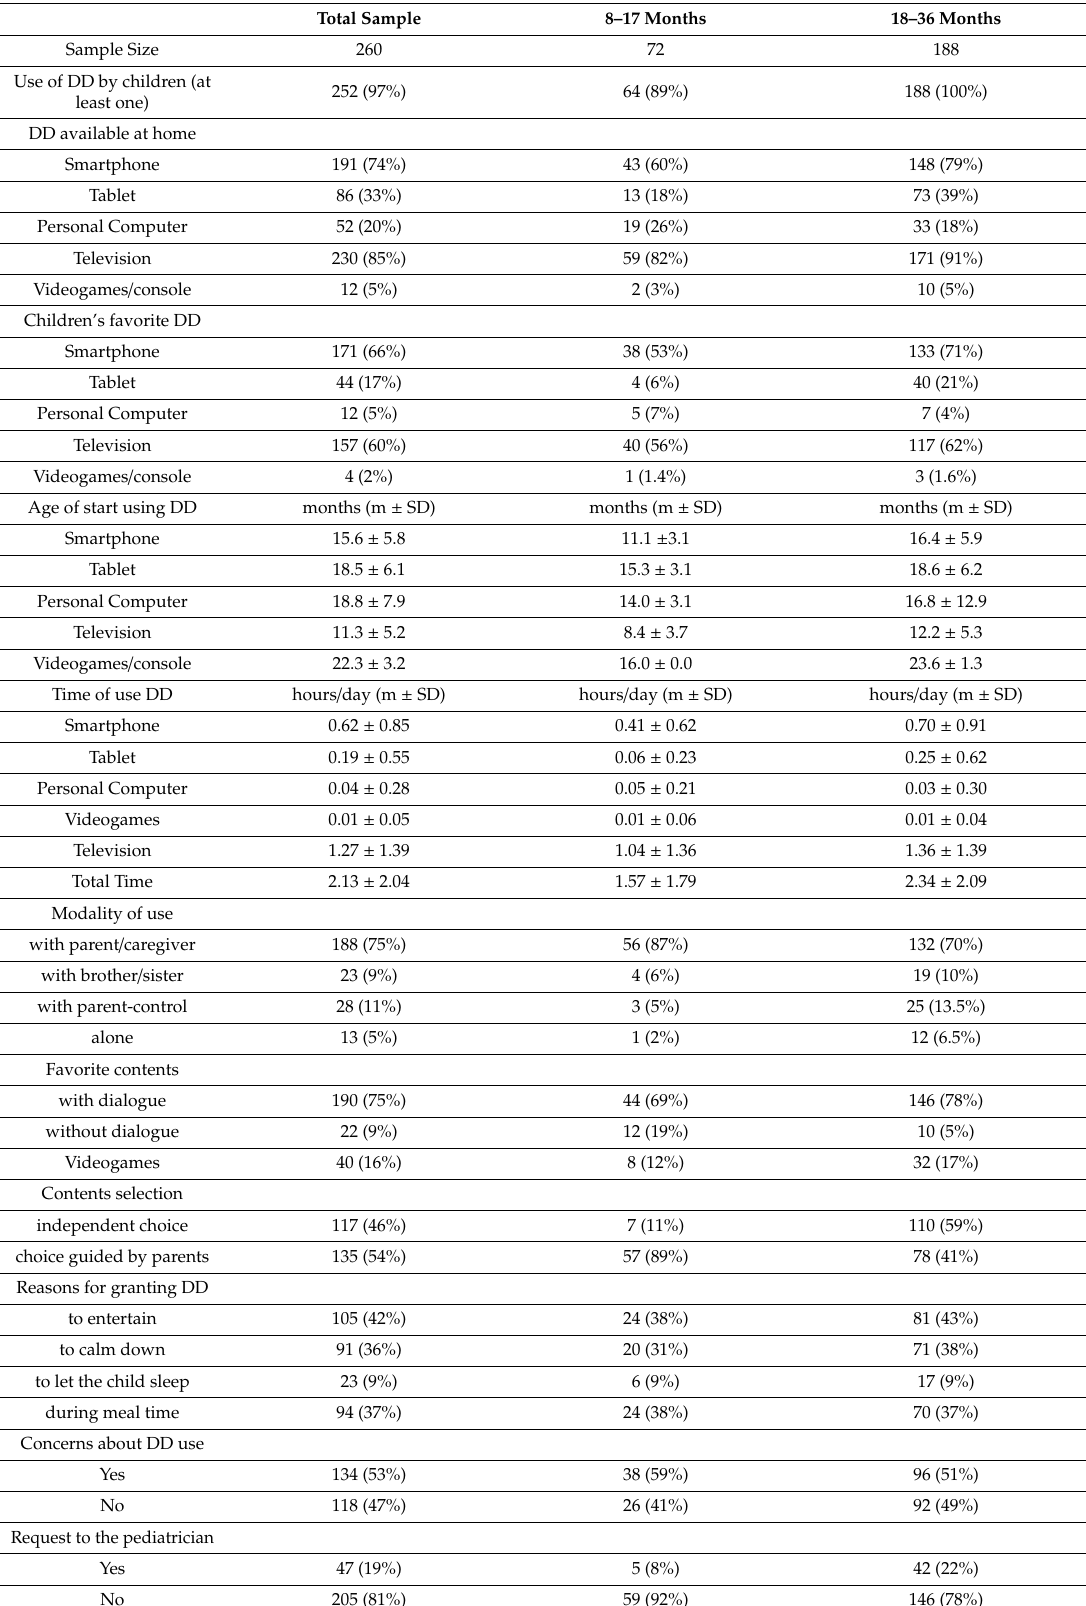
Table 2. Digital Devices Questionnaire; m = mean; SD = standard deviation; DD = digital devices; * (only for children ≥ 12 months, total sample size =